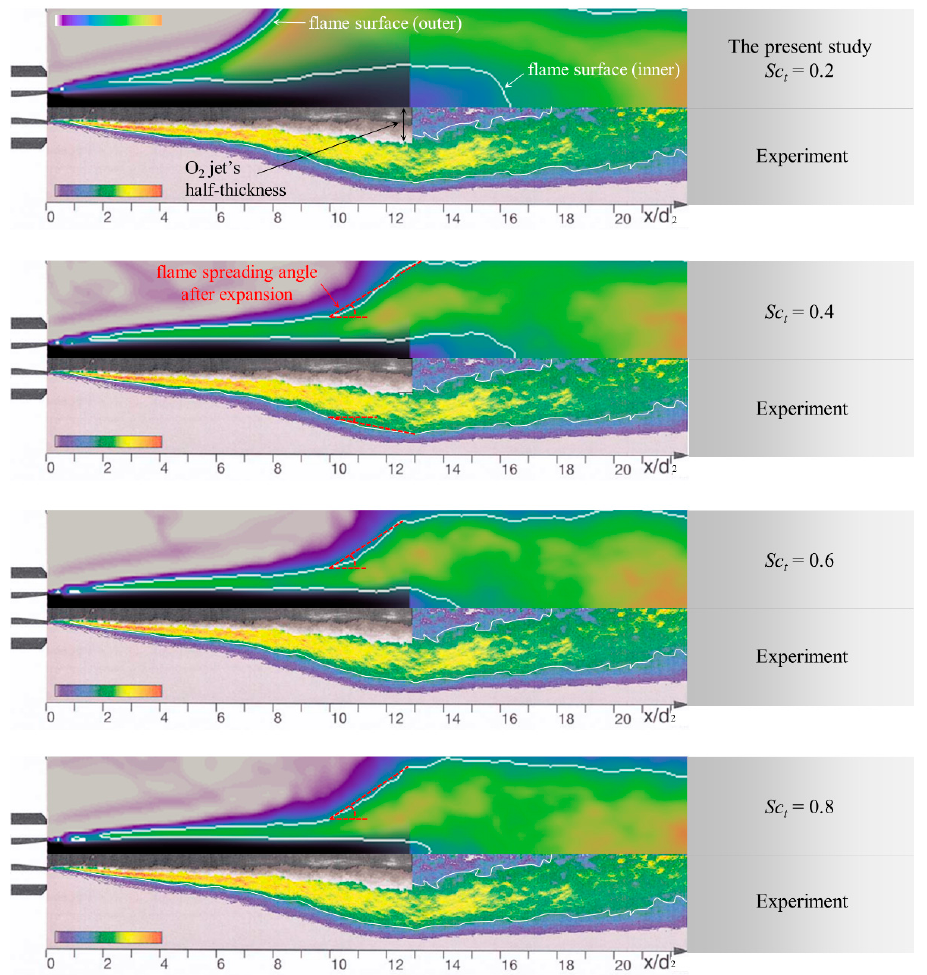
Figure 12. Time-averaged normalized OH in the near field of injector according to different turbulent Schmidt numbers for comparison between this study (upper part of each image) and experiment (lower part of each image).